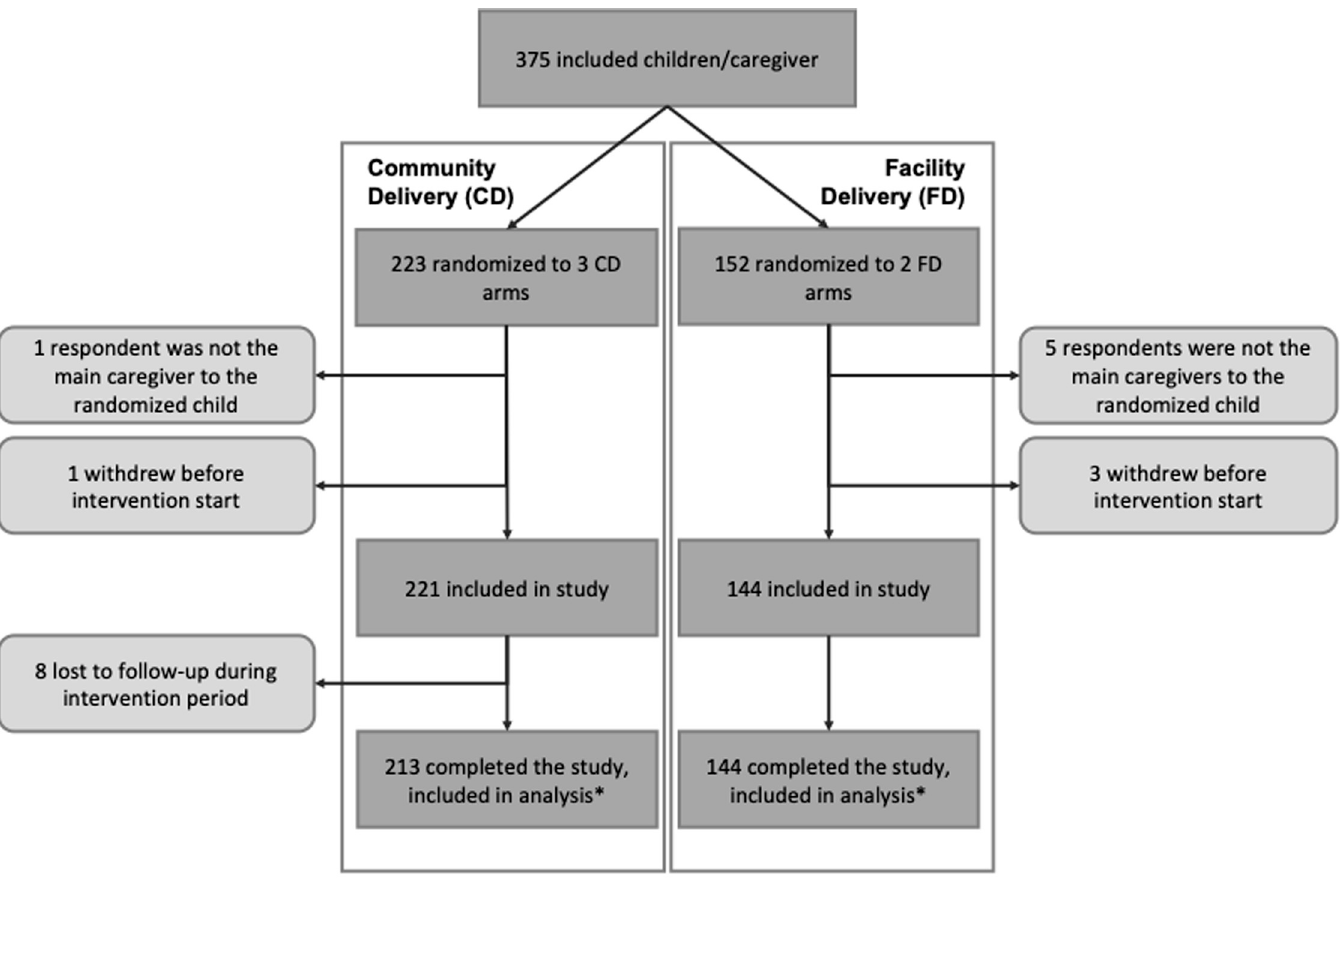
Fig 1. Study profile based on trial data from Gondwe et al, 2021